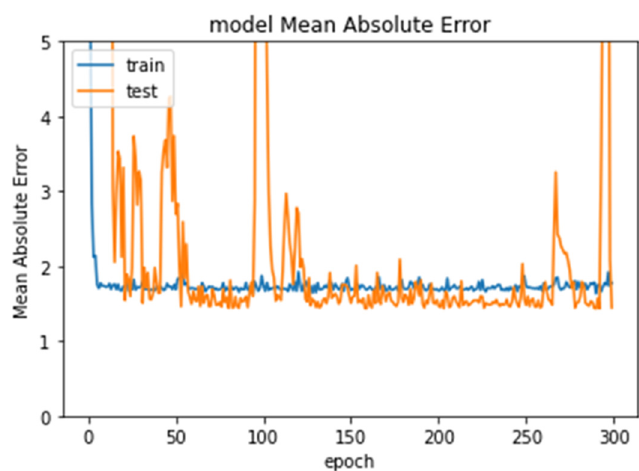
Figure 5. Error rate in Experiment 1 through epochs.